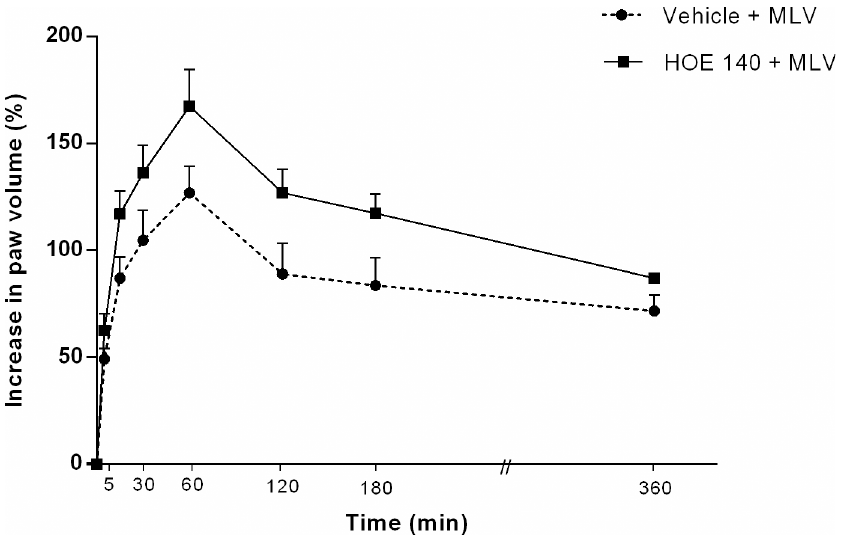
Fig 5. Effect of bradykinin BK 2 -receptor antagonist (HOE 140) on paw edema induced by Micrurus lemniscatus venom. Groups of animalswere treated with HOE 140 (5 μ g/paw) concomitantly with MLV (5 μ g/paw, i.pl.). The increase in volume of each paw (edema) was measured using a plethysmometer. Results were calculatedas the difference betweenhind paws and are expressedas a % increase in paw volume. Valuesare the mean ± SEM of five animals. None of the results were statistically